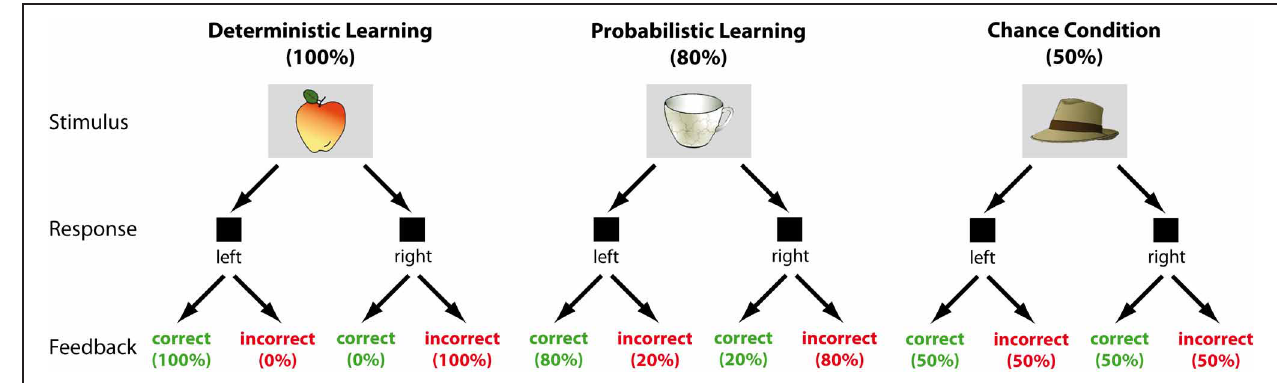
FIGURE 1 | Schematic illustration of the learning